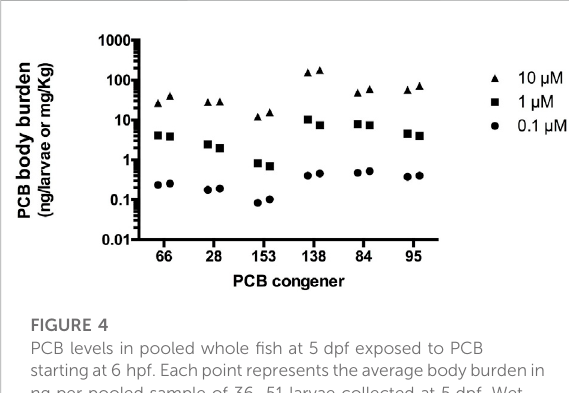
FIGURE 4 PCB levels in pooled whole fi sh at 5 dpf exposed to PCB startingat6 hpf.Eachpointrepresentstheaveragebodyburdenin ng per pooled sample of 36 – 51 larvae collected at 5 dpf.